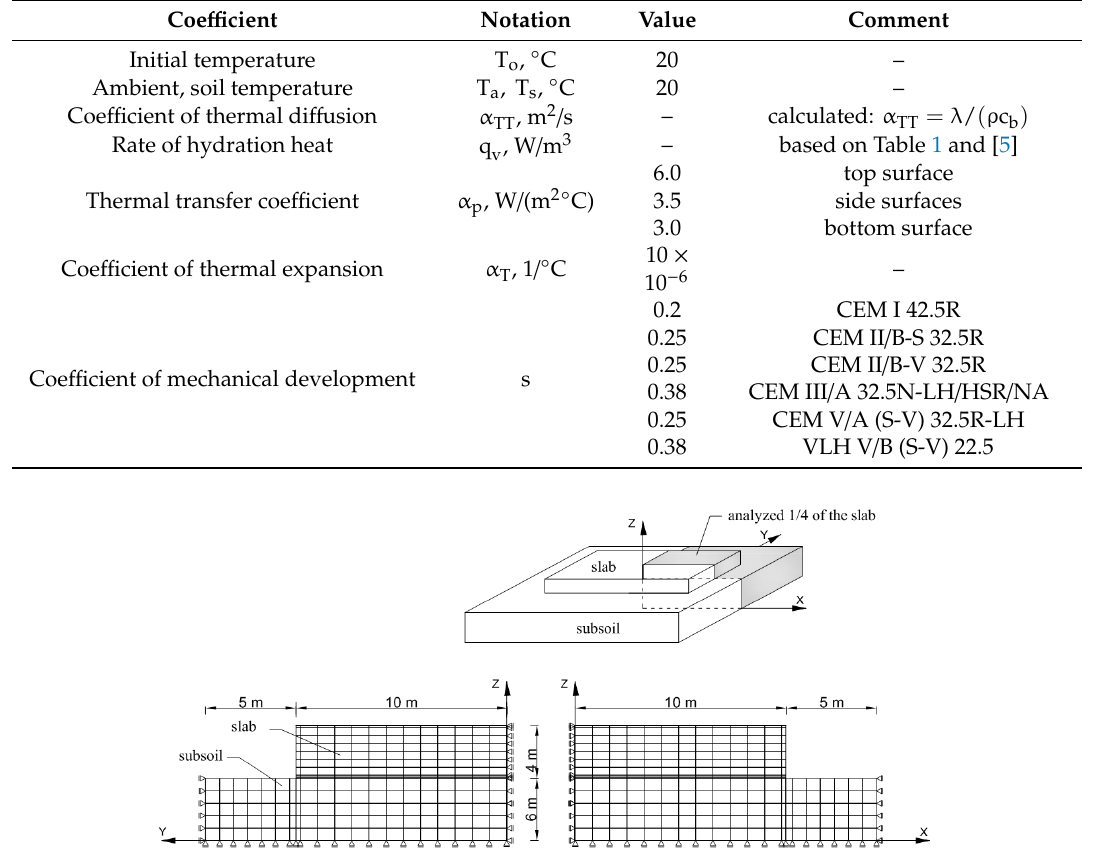
Table 10. Coe ffi cients used in numerical and analytical calculations.